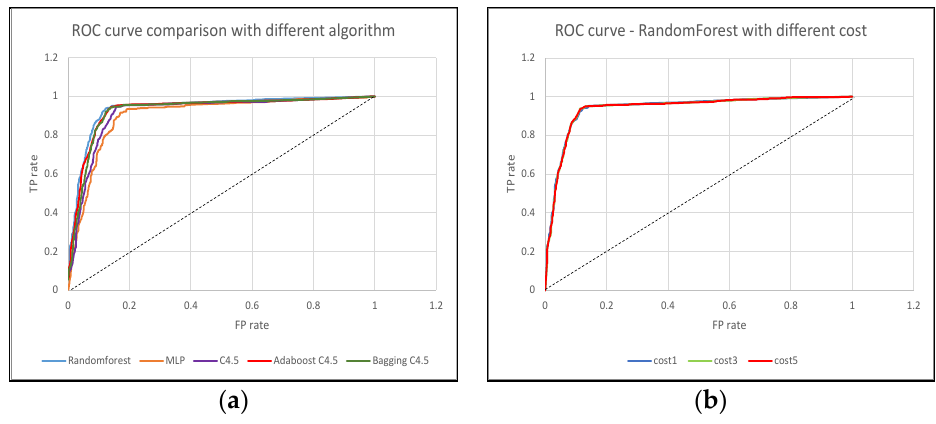
Figure 3. Comparison of the ROC curves of ( a ) different algorithms and ( b ) random forest with different FN costs. Table 2. Comparison of the classification performance for different algorithms.